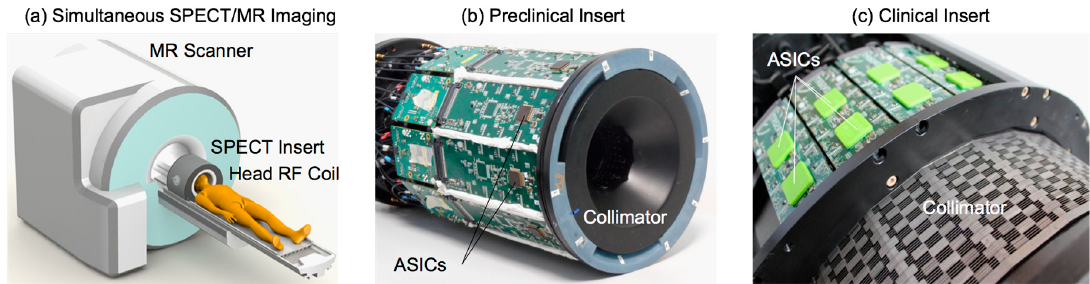
Figure 8. The INSERT family of MRI-compatible SPECT scanners featuring a static ring of gamma cameras: ( a ) shows the main concept of installation and components, ( b ) shows the preclinical system for small animals (10 modules), and ( c ) shows the clinical prototype for human brain studies (20 modules). Table 1. Summary of the INSERT performance.